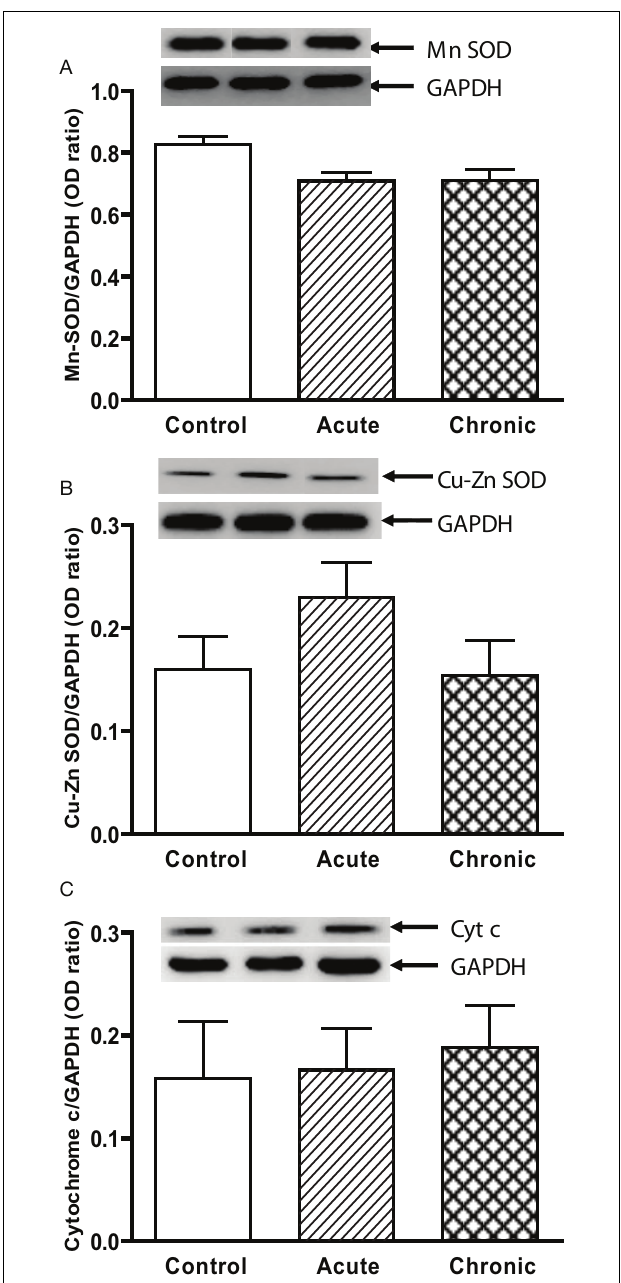
FIGURE 1 | Protein expression of (A) Mn SOD, (B) Cu–Zn SOD, and (C) cytochrome c in the striatum of young control, acute MPTP, and 6-week post-chronic MPTP/probenecid-treated parkinsonian (MPD) mice. Western blot technique and densitometry analysis were used to detect and quantify the respective anti-oxidant protein bands and GAPDH. The protein contents of Mn SOD, Cu–Zn SOD, and cytochrome c were expressed as a ratio to that of GAPDH to ensure that the changes in protein levels were not due to sample loading variances. A representative image of western blot protein bands was correspondingly shown above each set of bar graph. Each data point represents mean ± SEM, N = 6 per group of animals. The levels of Mn SOD, Cu–Zn SOD, and cytochrome c in the striatum of young control, acute MPTP, and 6-week post-chronic MPD mice were not statistically different from each other.